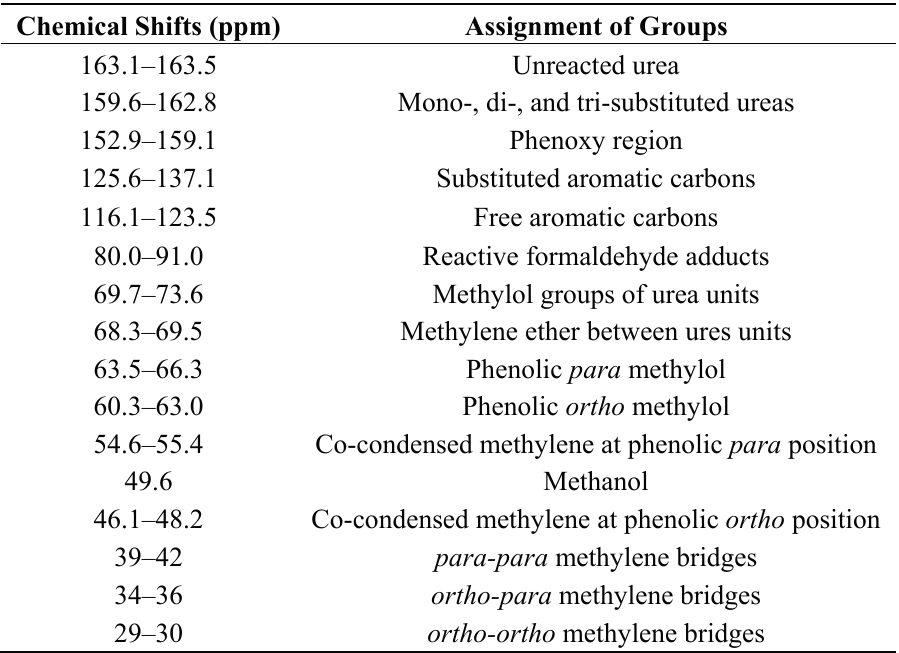
Table 2. Liquid 13 C-NMR chemical shifts and group assignments of PUF